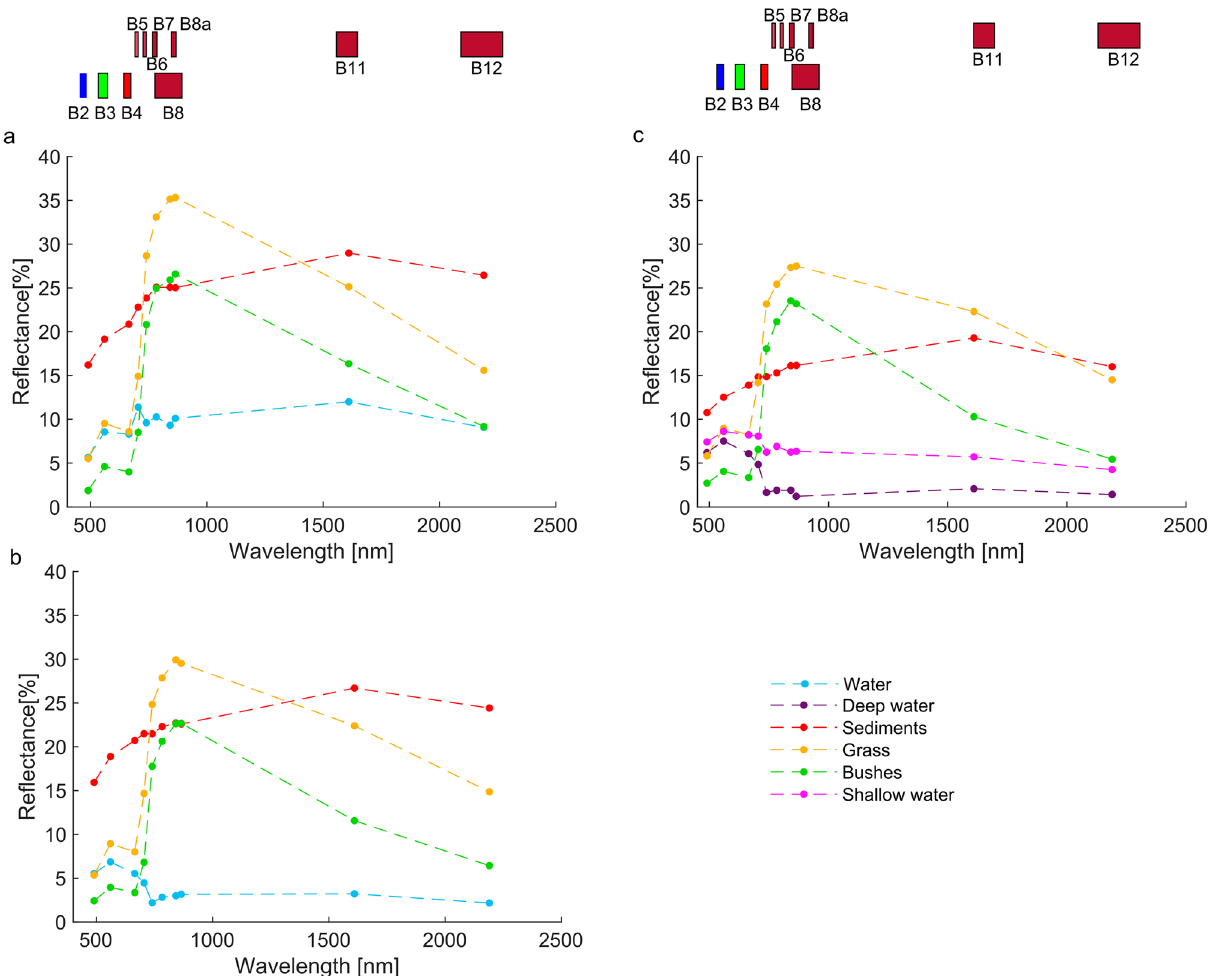
Figure 2. ( a ) Spectral signature of late spring season, Google Earth of June 2019, ( b ) spectral signature of winter, field pictures of February 2021, ( c ) spectral signature of late autumn season, ortophoto of December